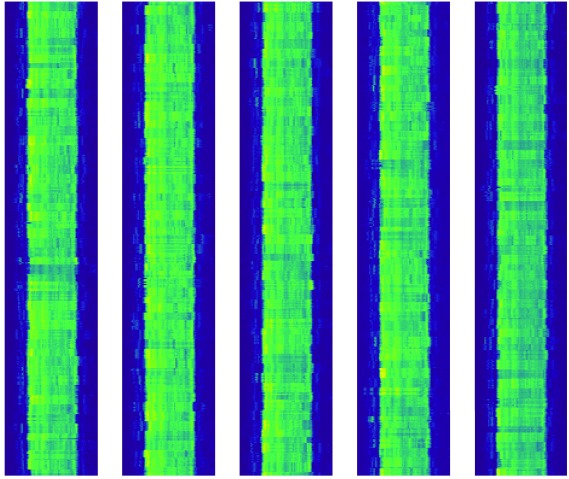
Visualization of the coregistration quality (hyperslab).Each line in all columns represents a single line of corresponding voxels from 1,969 preprocessed EPI images in MNI space (voxel coordinates i=20, k=50, t=10).